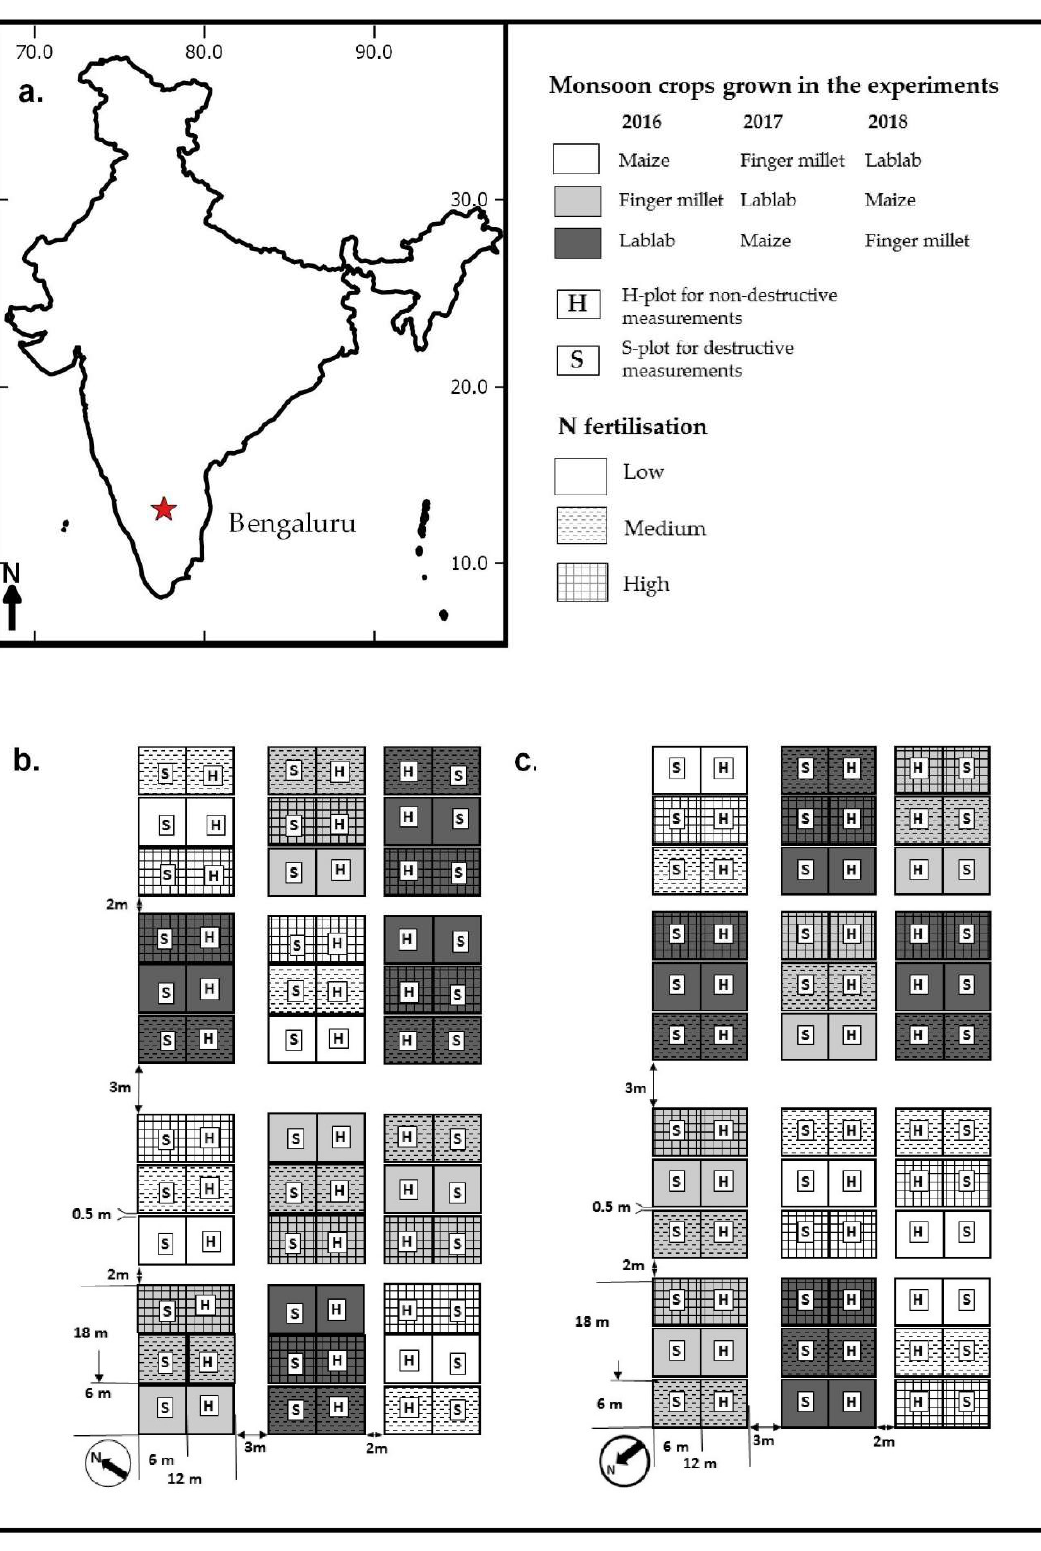
irrigated (I). Each year has two cropping seasons, namely rainy/monsoon season (July–November)